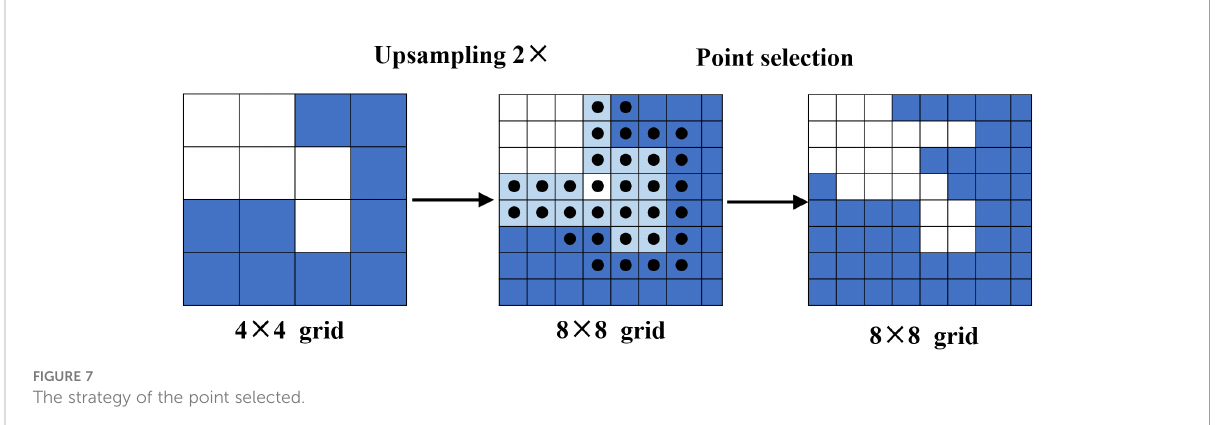
FIGURE 7 The strategy of the point